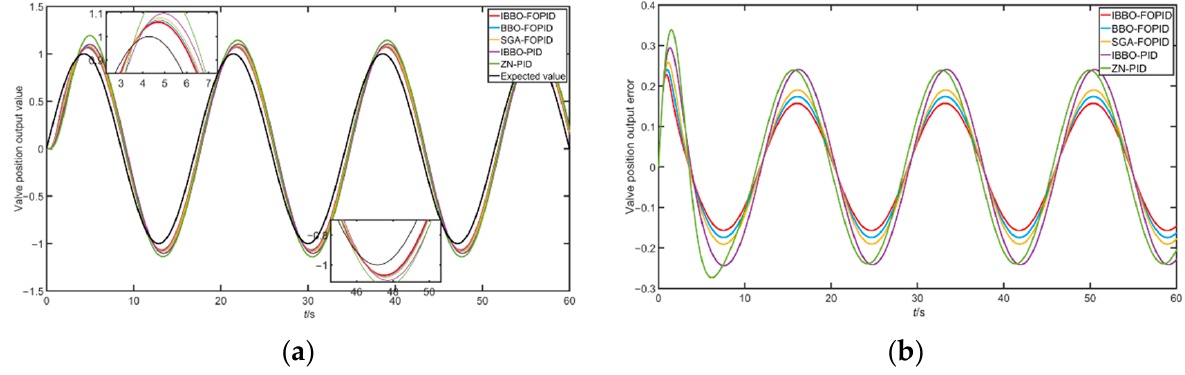
Figure 16. ( a ) Tracking curve of sinusoidal signal; ( b ) tracking error of sinusoidal signal.